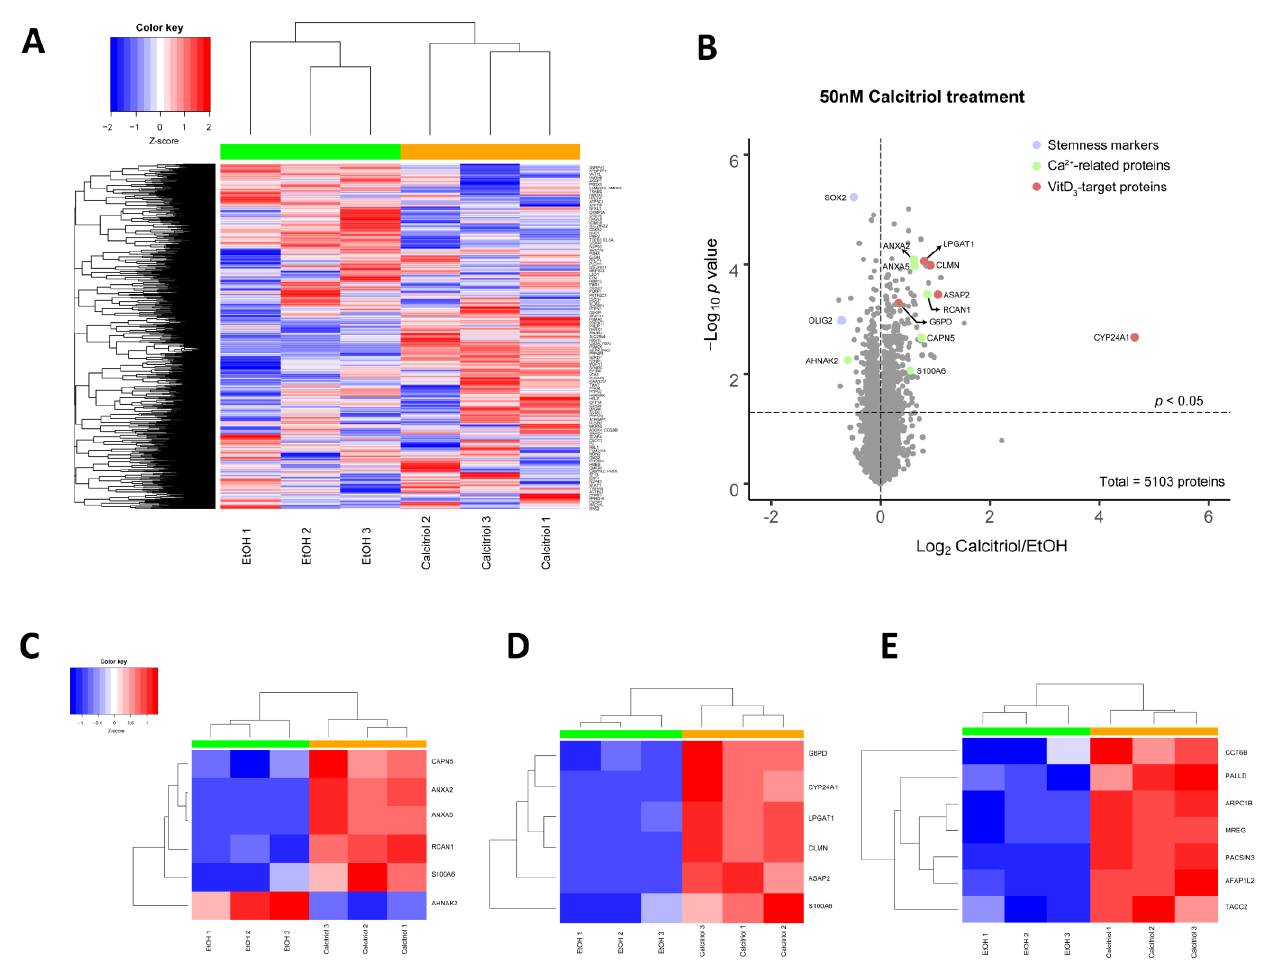
Figure 7. The effect of 48 h of calcitriol treatment on global protein levels: ( A ) hierarchal Euclidean clustered whole proteome indicates calcitriol similarly grouped and distinct profile of proteins. ( B ) Volcano plot showing fold-changes in calcitriol versus solvent for all quantified proteins. The stemness markers, Ca 2+ -related and vitamin D 3 -target proteins are also indicated and color coded on the plot. The heatmap represents Ca 2+ -related ( C ), vitamin D 3 -target ( D ) and actin/microtubules-related proteins ( E ).